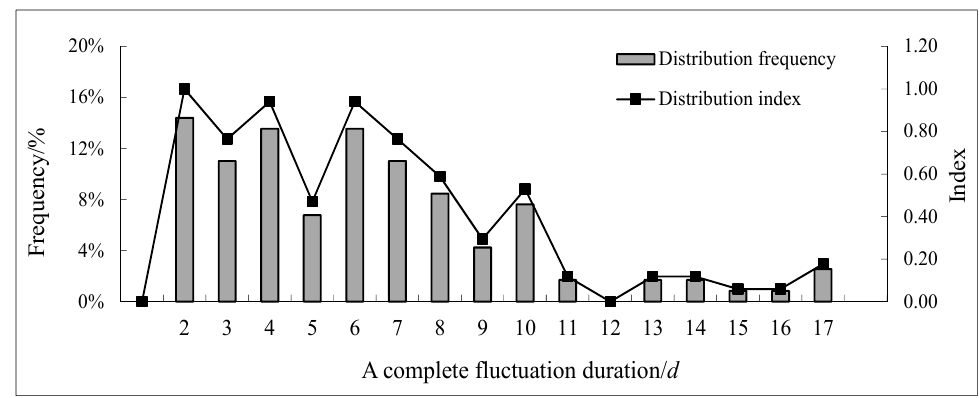
Figure 6. Distribution map of a complete fluctuation.